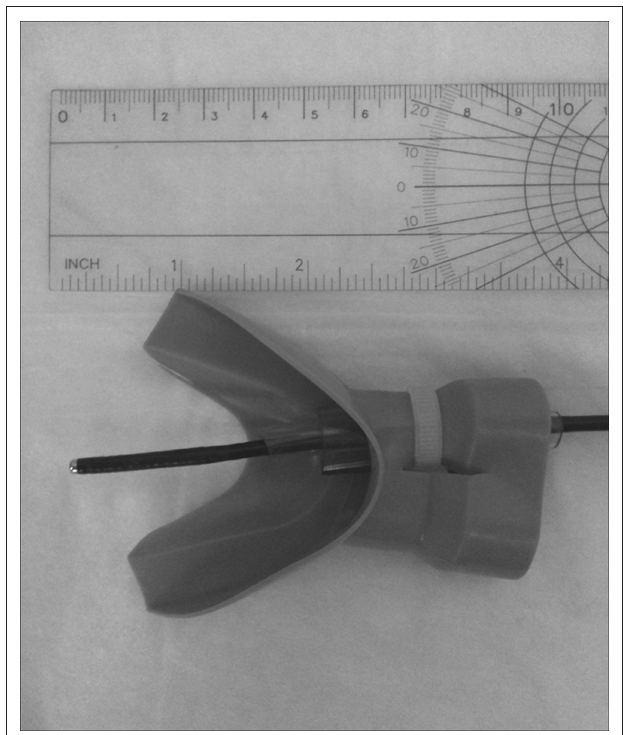
Figure 1 | Mouthpiece with polyurethane tubing used for placement of the flexible laryngoscope with the air puff delivery port. The laryngoscope was inserted posteriorly toward the oropharyngeal wall, therefore oriented at an approximately 90 °